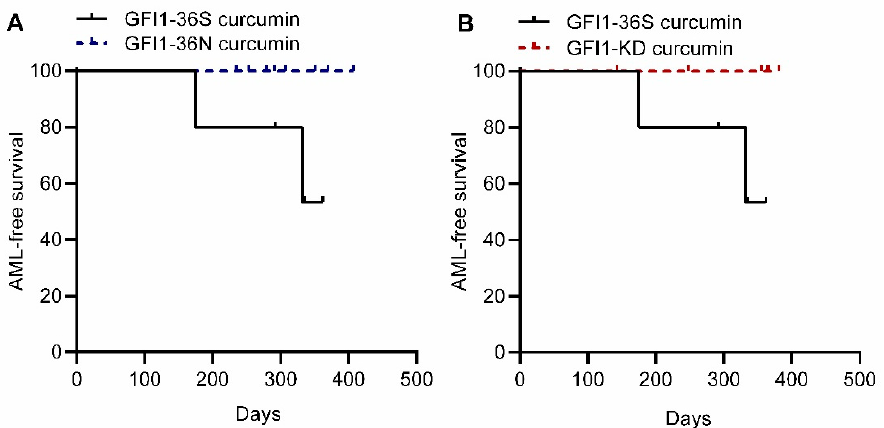
Figure A2. Curcumin treatment improved the overall survival of -36N and –KD, NUP98-HOXD13-tg mice. AML free survival in curcumin-treated GFI1-36S and -36N, NUP98-HOXD13-tg mice ( A ) or GFI1-36S and -KD, NUP98-HOXD13-tg mice ( B ) are presented.